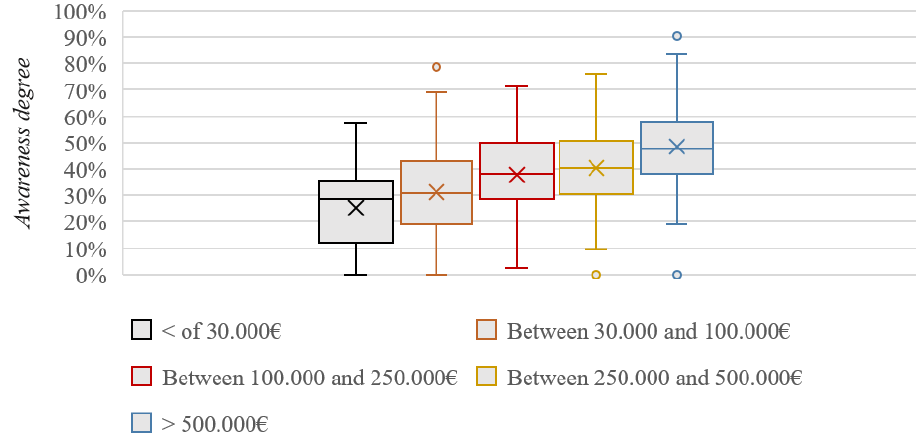
Figure 5. Boxplot graph of awareness level depending on company size (revenues).